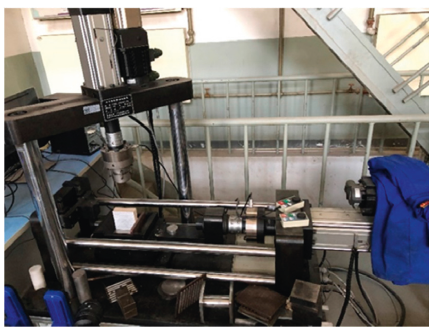
Figure 2: Shear testing machine of